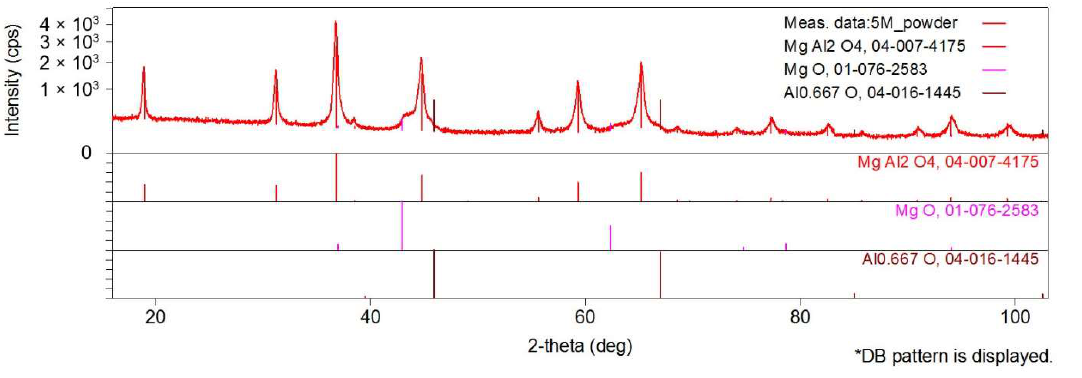
Figure A6. AZ63_10m in powder form sample—XRD qualitative phase analysis with displayed PDF cards peak bars. Figure A7. AZ63_20m in powder form sample—XRD qualitative phase analysis with displayed PDF cards peak bars. References 1.